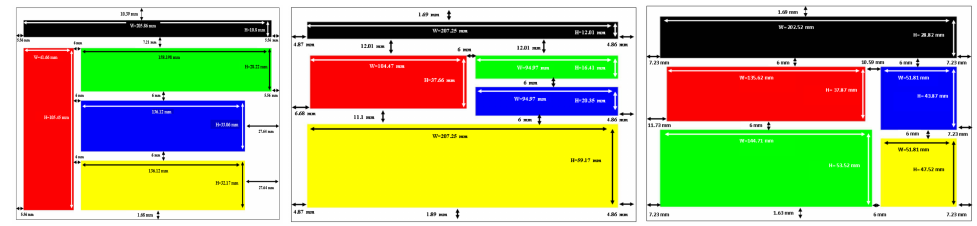
Figure 6. Clustering process of representative web pages.